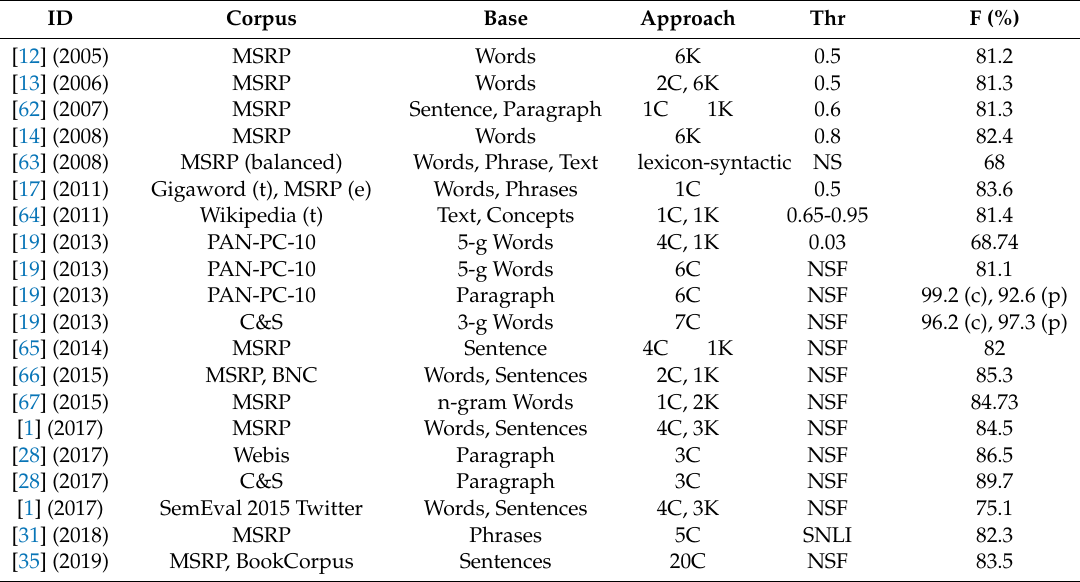
Table 4. Results of some previous research on unsupervised identification of text